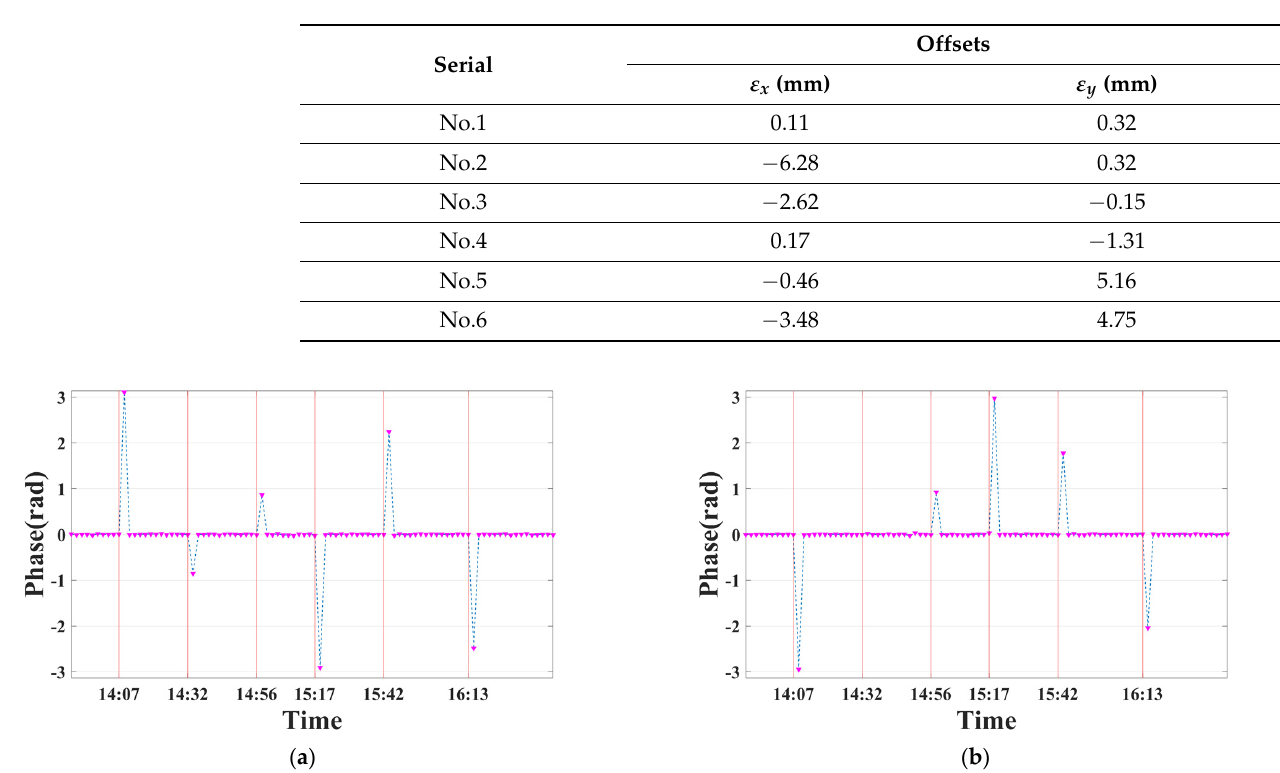
Table 3. Offsets of the radar center.